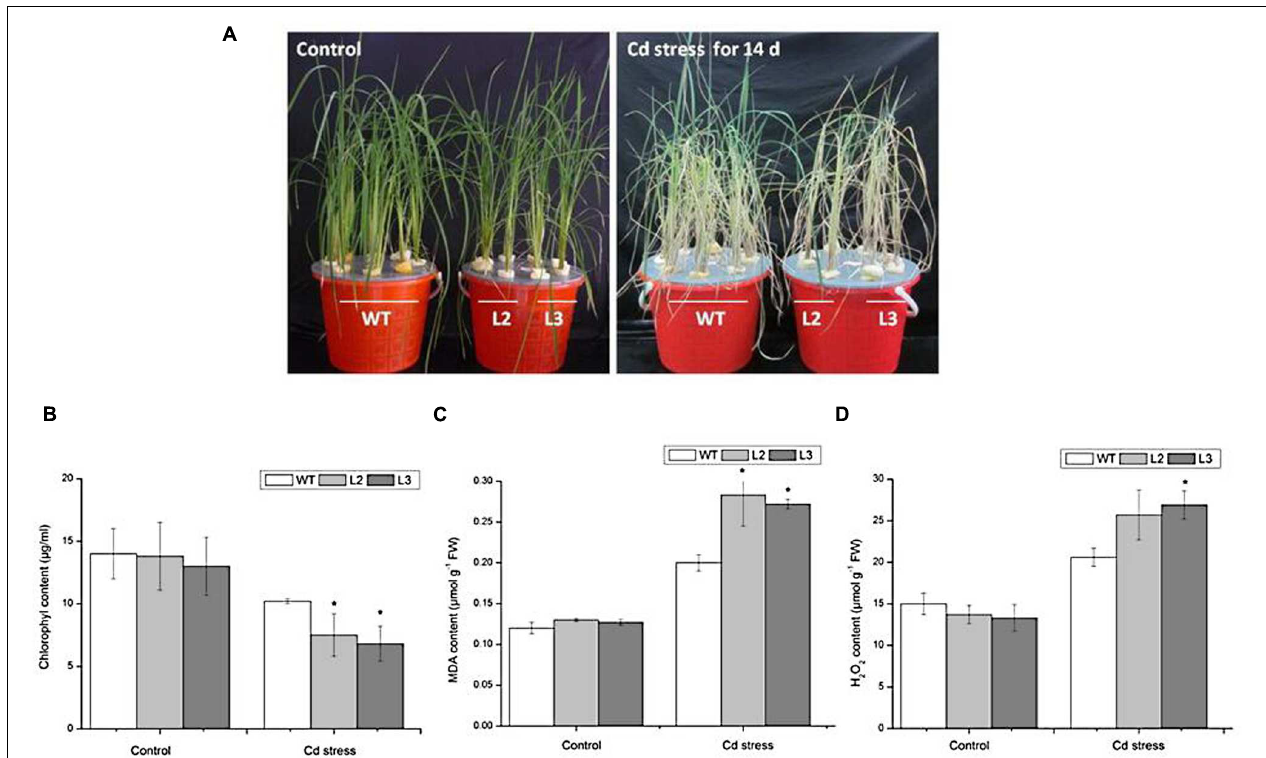
FIGURE 5 | Performance of wild-type and 35S:MIR390 transgenic plants treated with 150 µ M CdCl 2 for 14 days. (A) Phenotypic comparison of WT and 35S:MIR390 transgenic rice. (B) Chlorophyll content. (C) MDA content. (D) H 2 O 2 content. Each column represents an average of three replicates, and bars indicate SE. ∗ Indicate significant differences from between wild-type and transgenic plants at P <